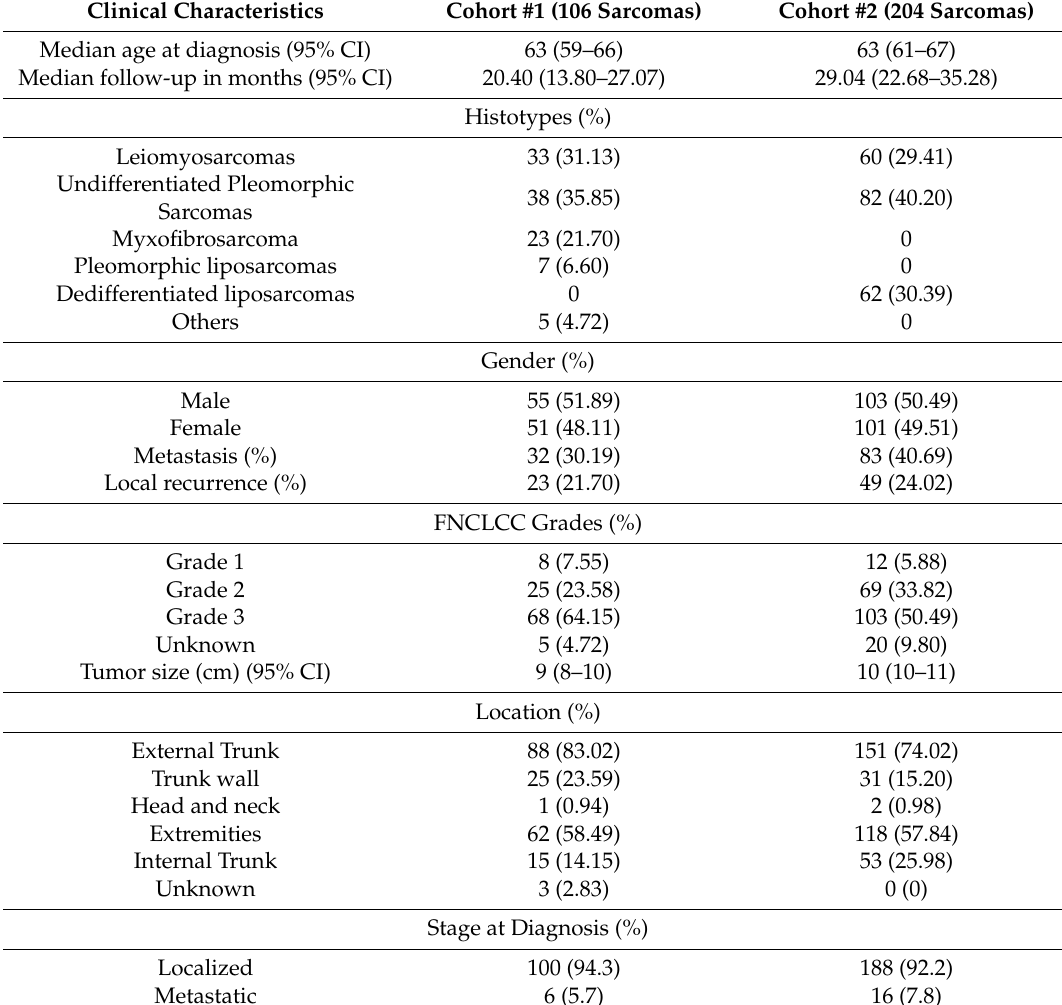
Table 1. Patient characteristics of cohorts #1 and #2. UPSs: undifferentiated pleomorphic